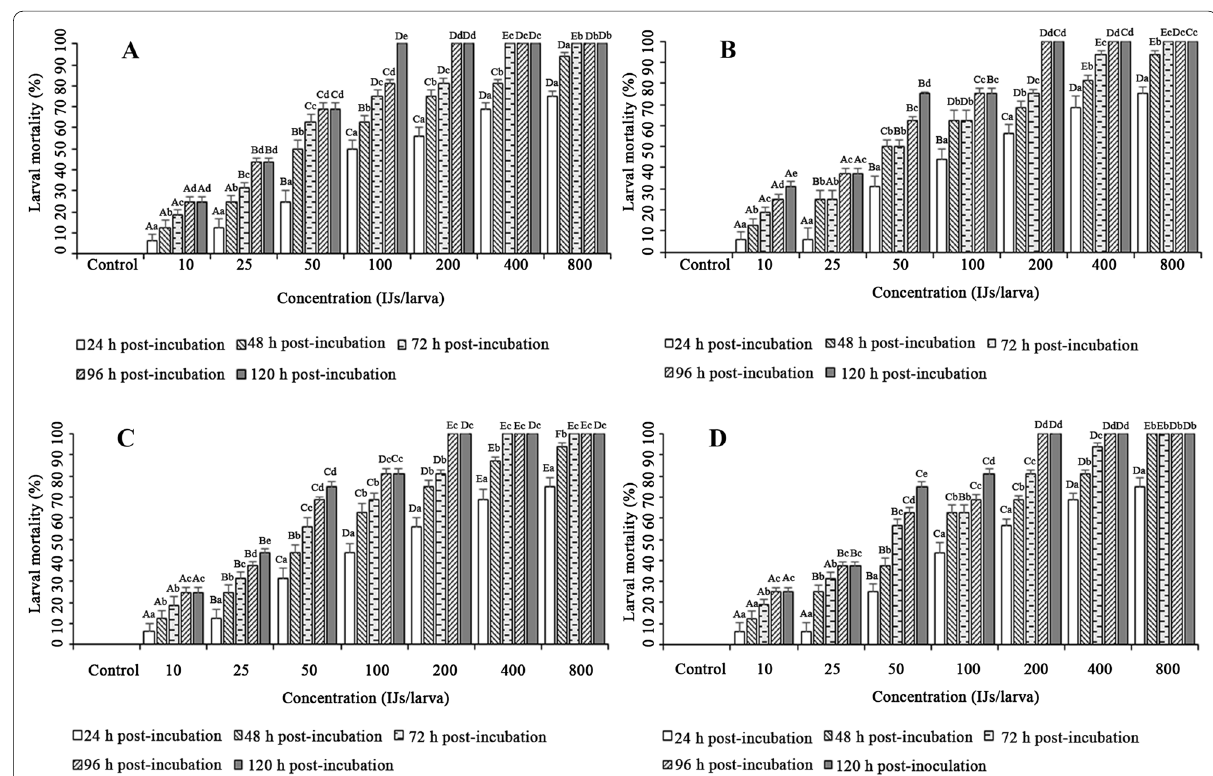
Fig. 3 Percentage mortality of 5th instar larvae of Spodoptera frugiperda upon exposure to different concentrations of nematodes. A Heterorhabditis indica , B H. baujardi , C Steinernema sangi and D S.